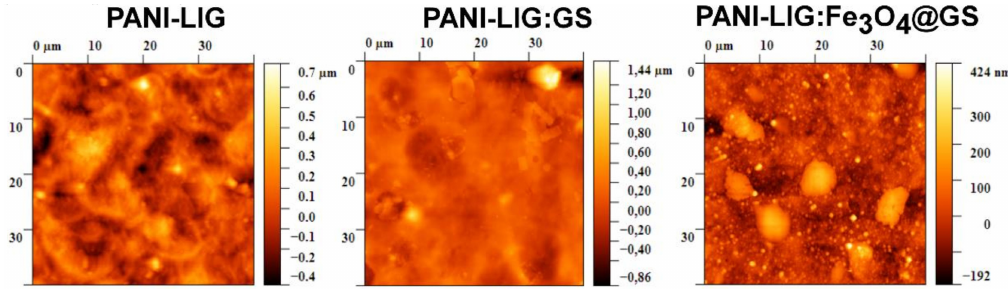
Figure 4. Atomic force microscopy (AFM) images of PANI-LIG-based